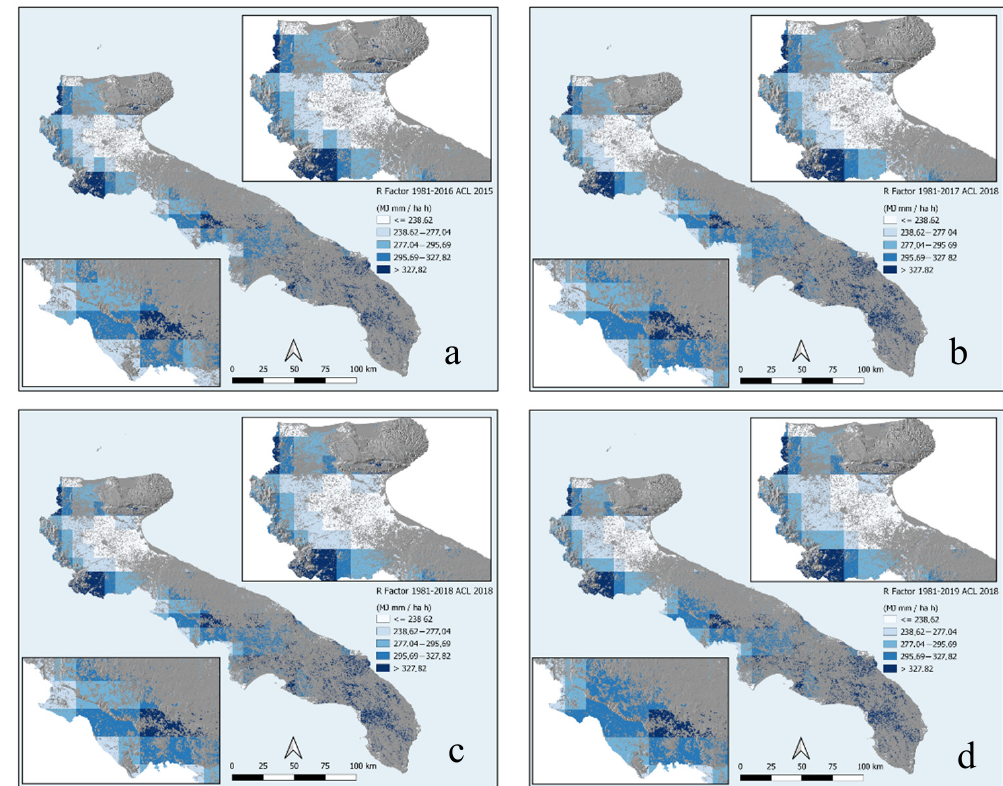
Figure 5. Maps of rainfall erosivity factor ( R ) of Apulia region with Era-5 land (9 km resolution) for the periods ( a ) 1981–2016, ( b ) 1981–2017, ( c ) 1981–2018, and ( d ) 1981–2019.